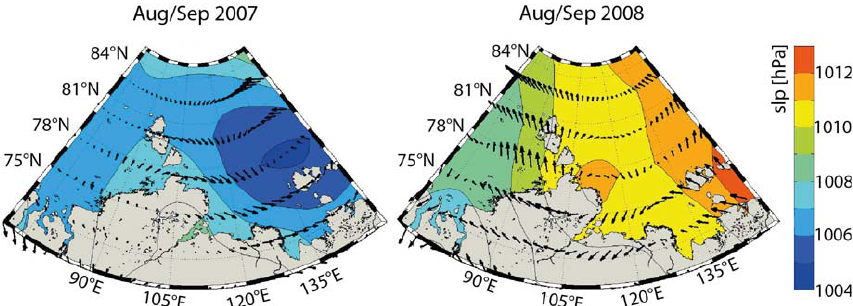
729 Fig. 2. Average sea level pressure (slp [hPa]) and prevailing wind directions during August to September 2007 and 2008. NCEP